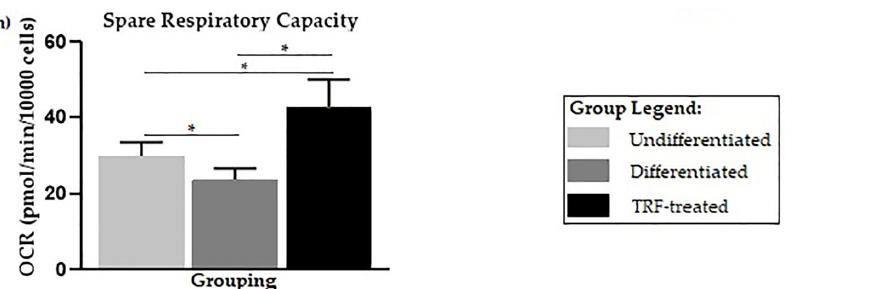
Figure 3. Cellular metabolic changes. Higher basal respiration in differentiated cells and treatment with TRF improves mitochondrial bioenergetic function. ( a ) Overall flux analysis graph, which is further analyzed from multiple aspects of mitochondrial bioenergetic functions: ( b ) Total oxygen consumption rate, ( c ) Extracellular acidification rate, ( d ) Basal respiration, ( e ) Maximal respiration, ( f ) Proton leak, ( g ) ATP production, and ( h ) Spare respiratory capacity. Note: Bioenergetic parameters ( d – h ) were calculated from each event. Parameters ( b – e ) were analyzed using one-way ANOVA followed by Tukey’s multiple comparison test, while ( f – h ) were analyzed using Welch ANOVA followed by the Games–Howell multiple comparison test. * indicates p <